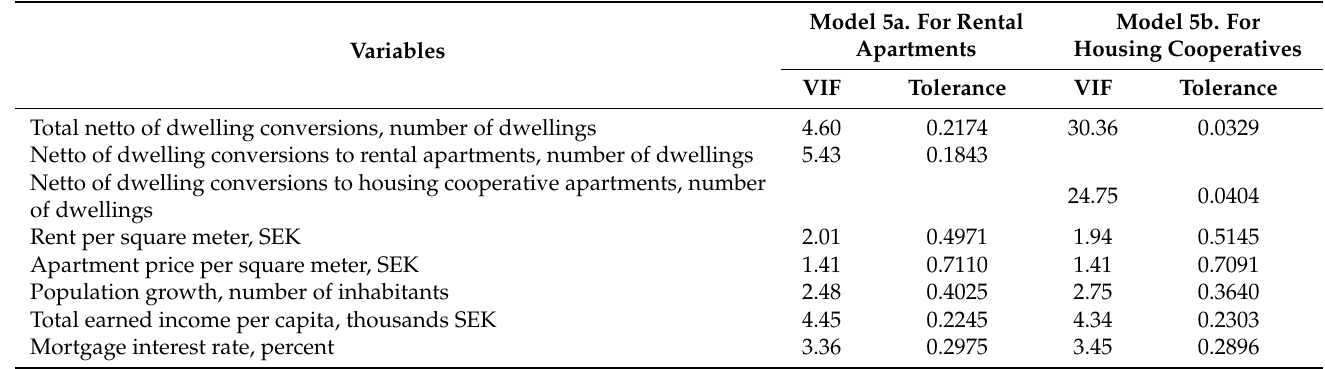
Table A8. Results of the VIF tests on variables in models 5a and